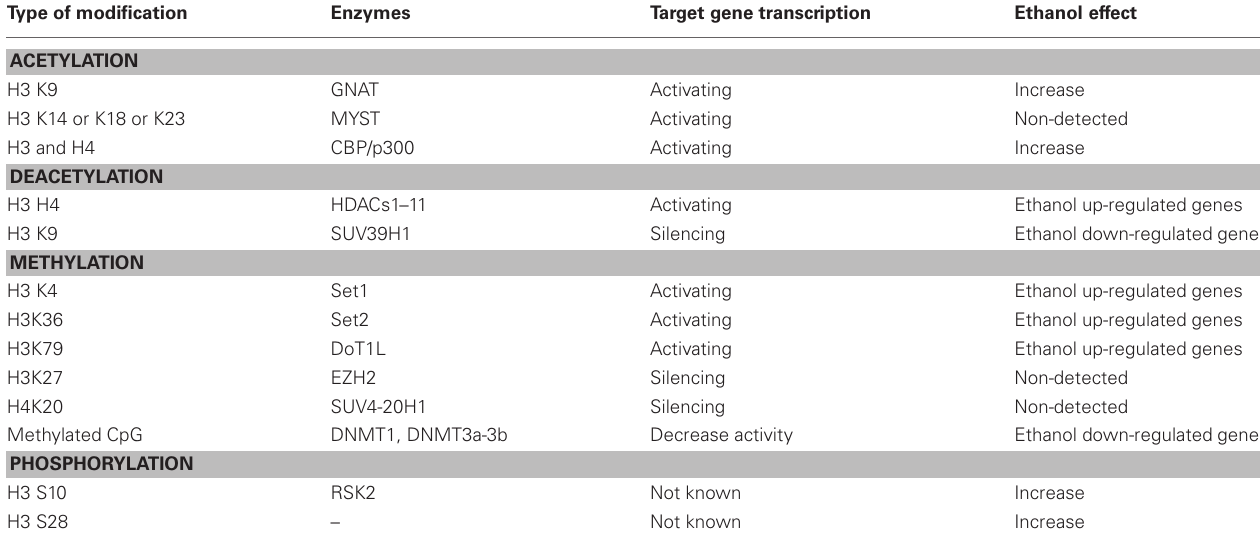
Table 3 | Ethanol-induced histone and DNA